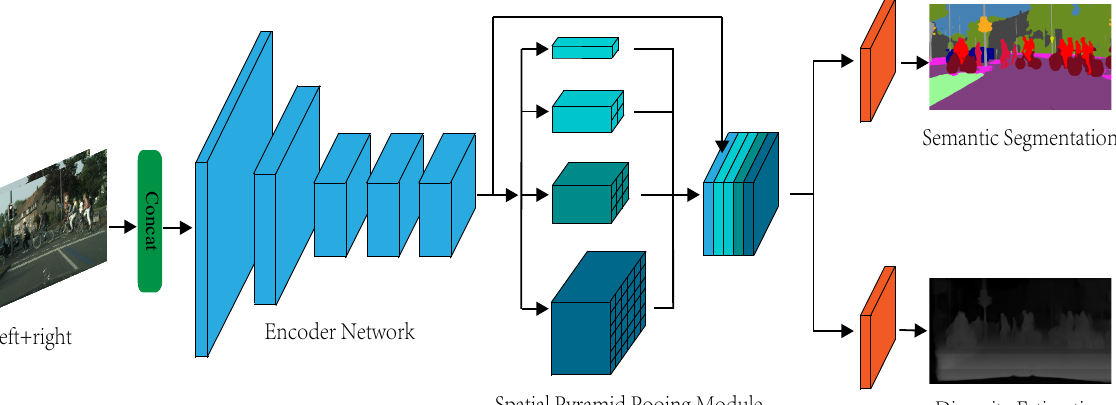
Figure 4. Overall network architecture. The network follows the classic encoder–decoder architecture. ResNet [2] with dilated convolution and the SPP module together serve as the encoder. The encoder directly concatenates the stereo images along the channel dimension and takes them as input. Beyond the encoder, each decoder only consists of a 1 × 1 convolution layer and a bilinear interpolation up-sampling layer for final